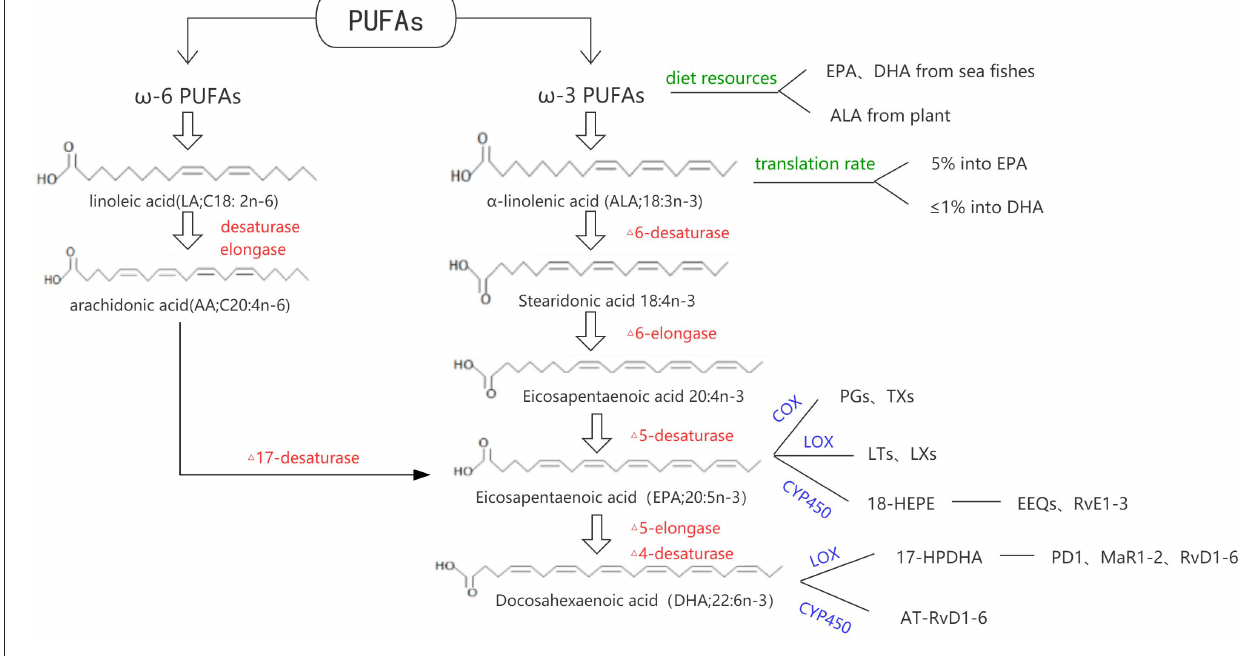
FIGURE 1 | Metabolic pathway of PUFAs.